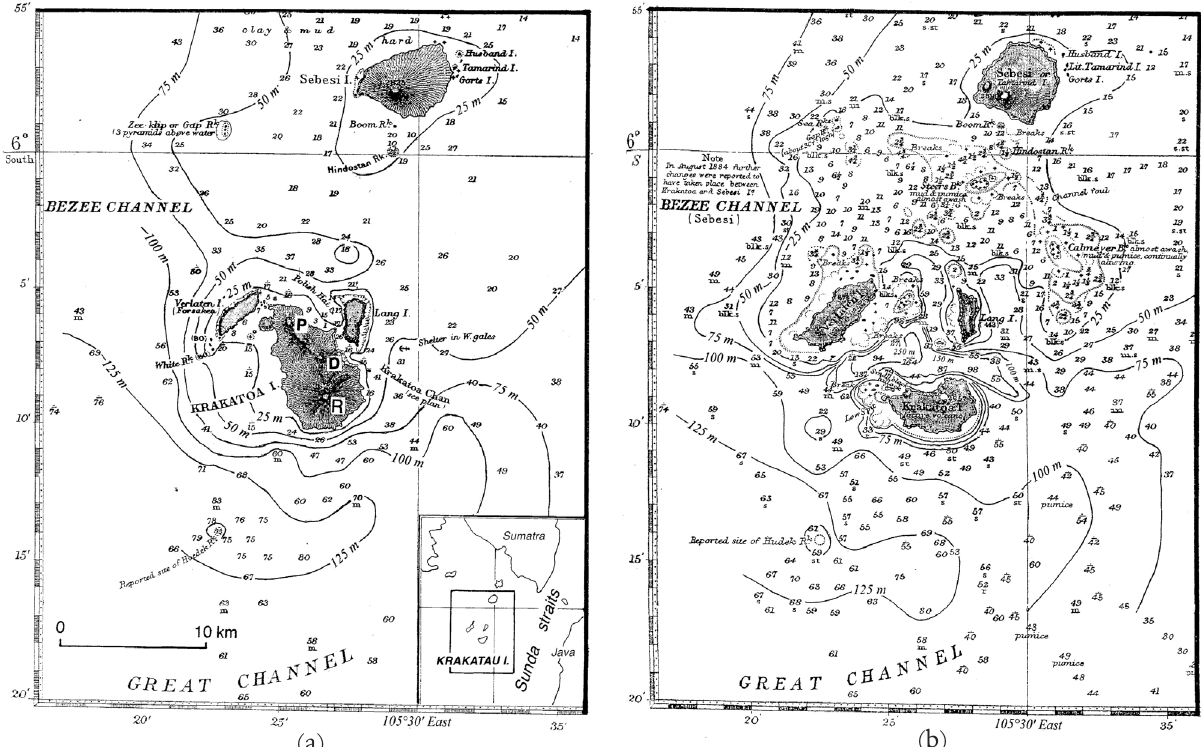
Figure 3. British Admiralty Charts surveyed before and after the 1883 eruption of Krakatau. In both the figures, the isobaths are added every 25 m by the present author. (a) Chart surveyed in 1854. Spot depths are in fathom (1 fathom = 1.83 m). ⓢ and ⓒ denote the locations of Steers and Calmeyer reefs, respectively. P Perbuwatan, D Danan, R Rakata. (b) Chart surveyed in 1886. The central region collapsed to a depth of 250 m at the